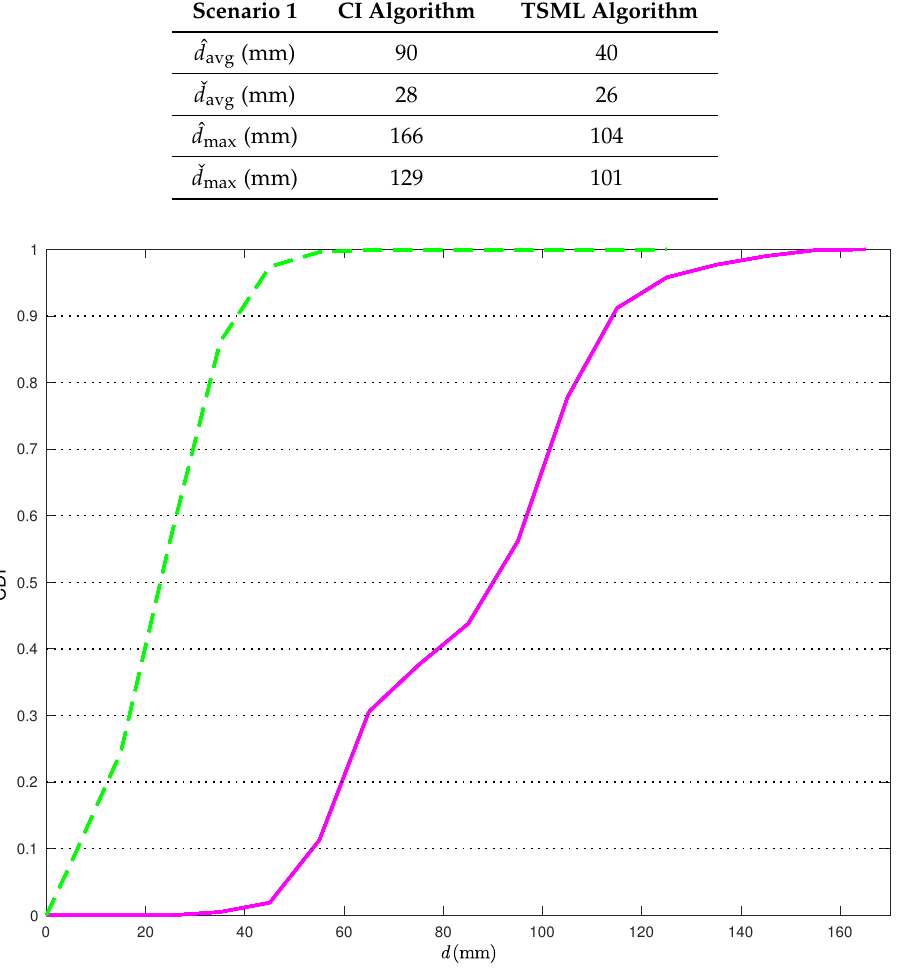
Figure 7. CDFs of the distance errors obtained with the CI localization algorithm in Figure 6 without (solid line) and with (dashed line) the application of the statistical model on the distance estimation